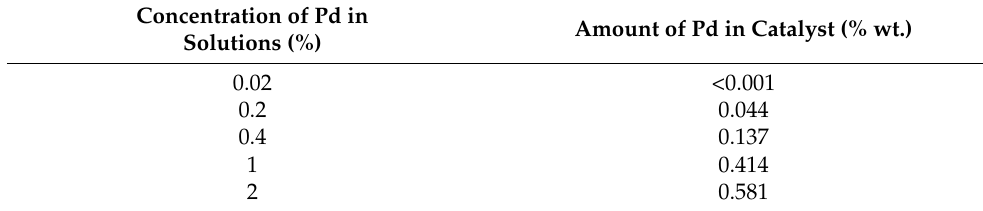
Table 1. Amount of Pd in Pd/TiO 2 /Ti catalysts.